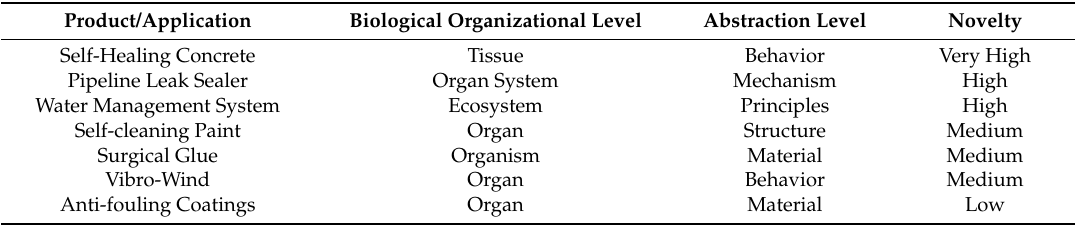
Table 1. Full classification of seven biomimetic